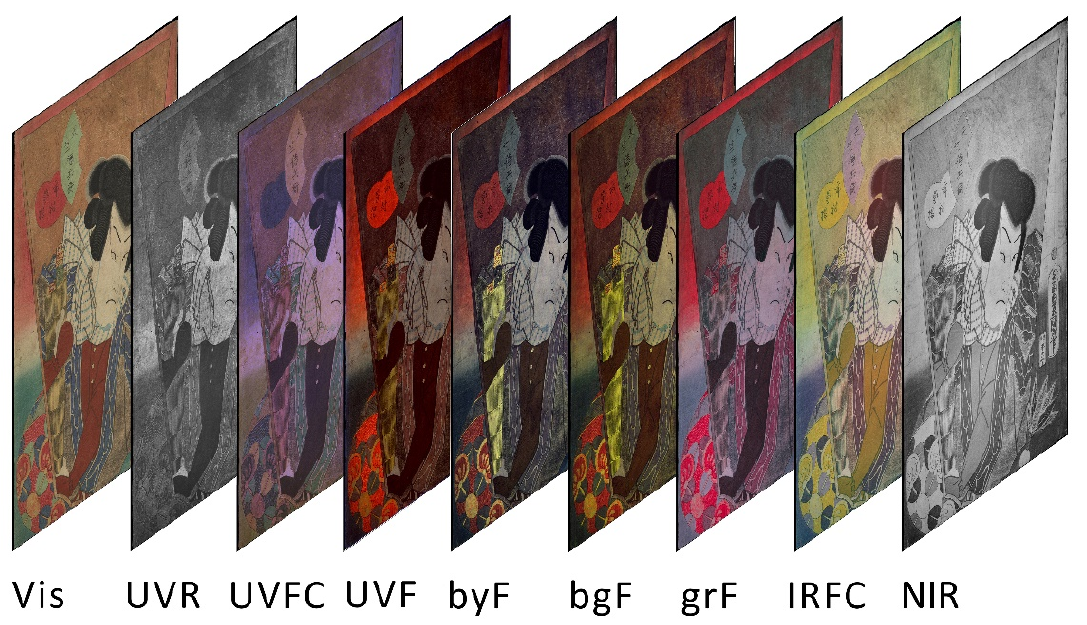
Figure 1. Schematic representation of all the multiband imaging acquisitions performed on each woodblock print as detailed in Table 2. Table 2. The methods of imaging acquisition with specifications of excitation ( λ exc ), acquisition ( λ acq ) wavelengths and abbreviations used in the